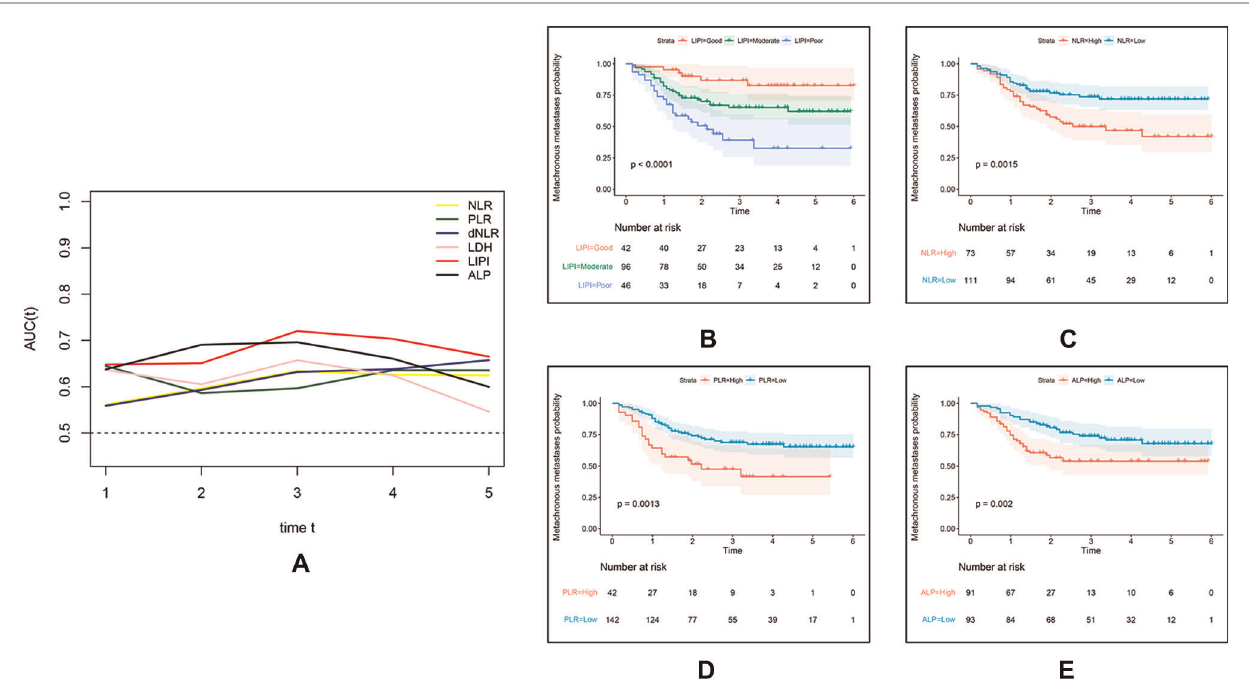
FIGURE 2 | Comparison of different hematological factors in predicting the metastatic probability. ( A ) The difference of predictive ability is shown in a time-dependent ROC curve, in which a larger AUC value means a better metastatic predictive ability. ( B , C ) Metastatic predictive ability of different hematological factors in 184 osteosarcoma